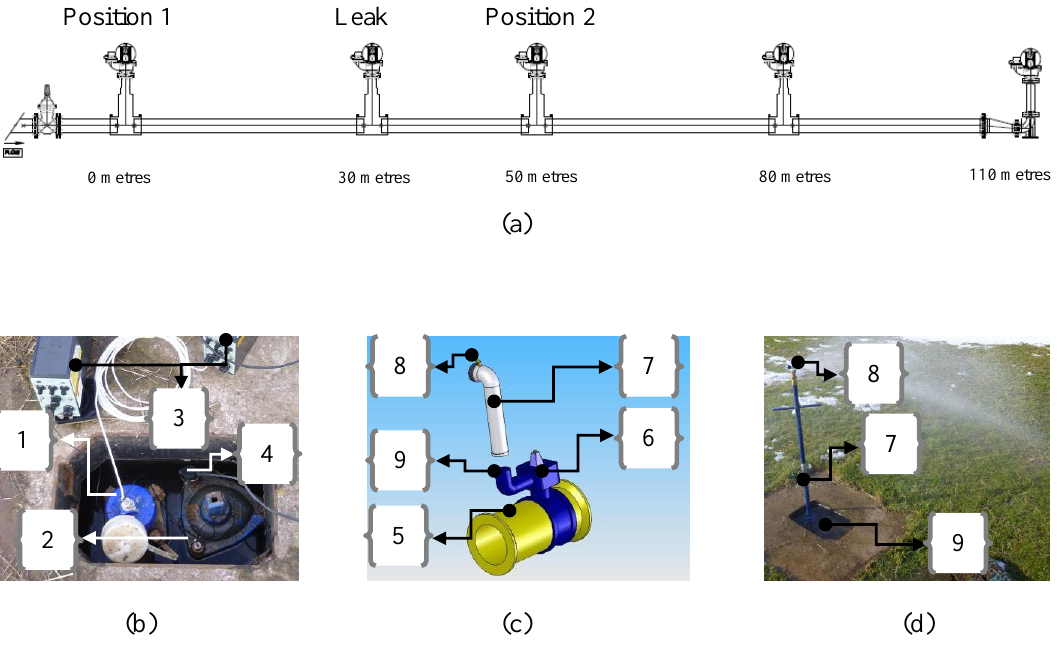
Figure 3. Details of the Blithfield pipe test-rig. ( a ) schematic showing the distances and the excitation/measurement positions and the leak position; ( b ) One of the access points and part of the instrumentation used. {1} Hydrophone; {2} Accelerometer; {3} Charge amplifier; {4} Geophone; ( c ) Sketch of the device used for generating the leak condition. {5} Water distribution plastic pipe; {6} Main valve; {7} Standpipe; {8} Secondary